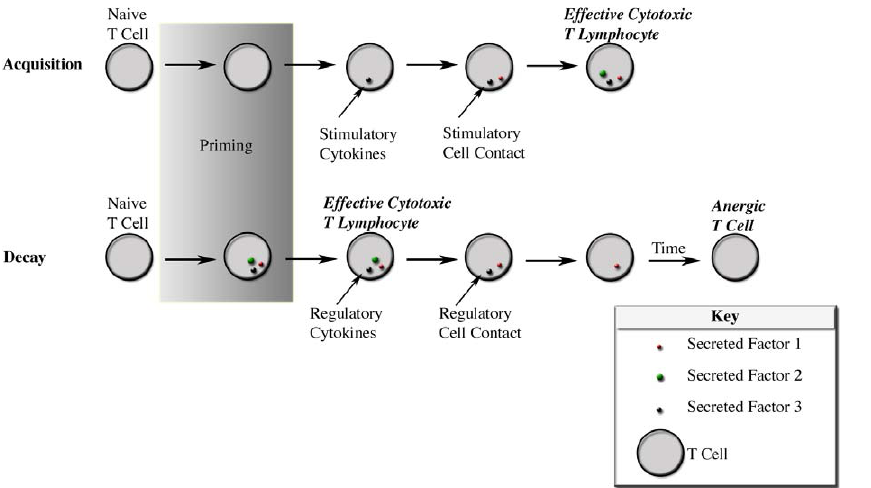
Figure 8. Two Models of T-Cell Function Acquisition and decay models depict two possible mechanisms that account for variability in the factors secreted by activated CD8 þ T lymphocytes in response to antigen recognition. Acquisition refers to independent, sequential increases in responsiveness to activation, triggered by both cellular and secreted signals. Decay accounts for maximally functional T cells immediately upon completion of priming, after which signals, or time, lead to diminished responsiveness to